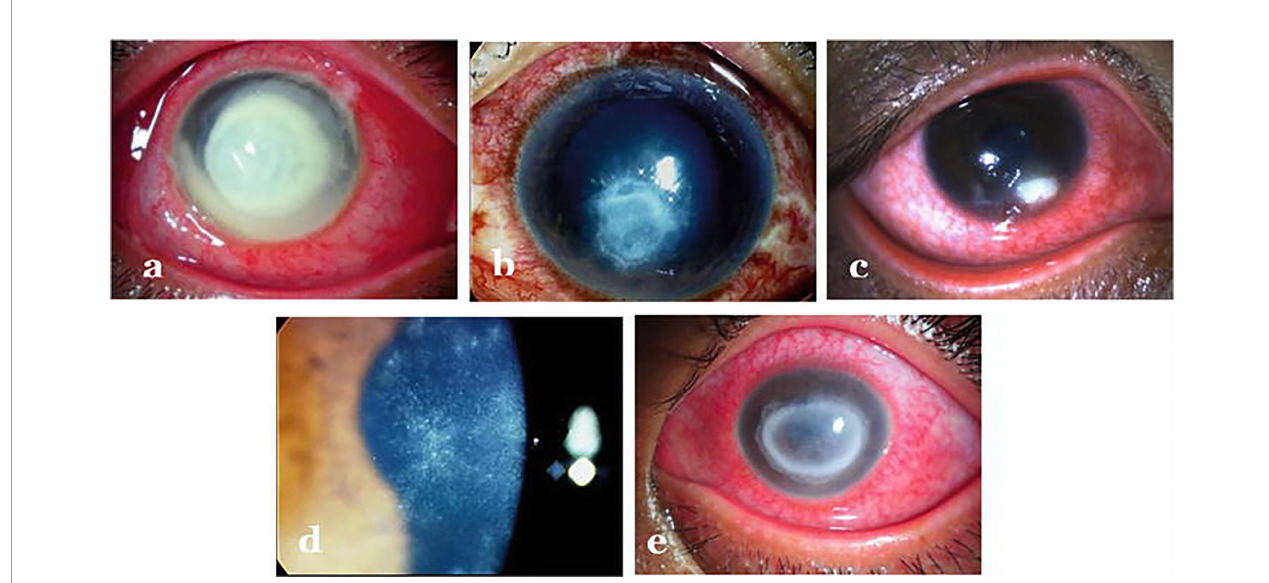
FIGURE 2 | Infectious keratitis caused by different agents: (A) Bacterial keratitis (B) Fungal keratitis (C) Herpes necrotizing stromal keratitis (D) Early Acanthamoeba keratitis (E) Late Acanthamoeba keratitis. Adopted from https://www.intechopen.com/chapters/69696 under Creative Commons Attribution 3.0